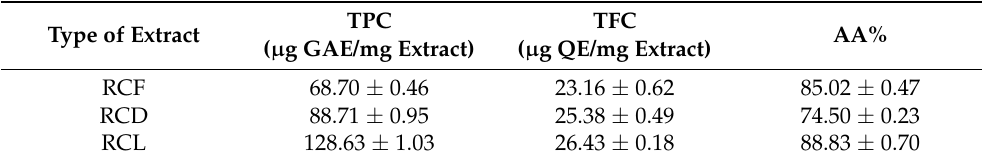
Table 2. TPC, TFC, and AA% of Rosa canina L.